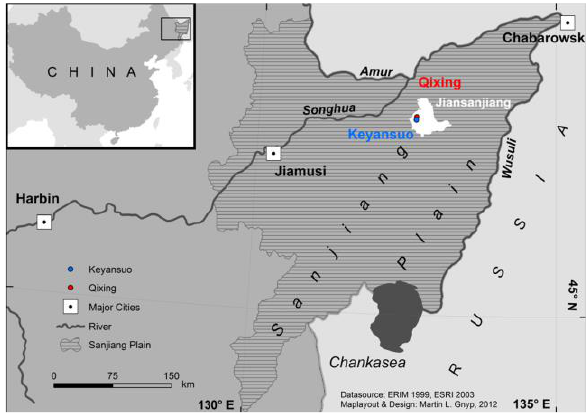
Figure 1. Location of the experiment fields Qixing and